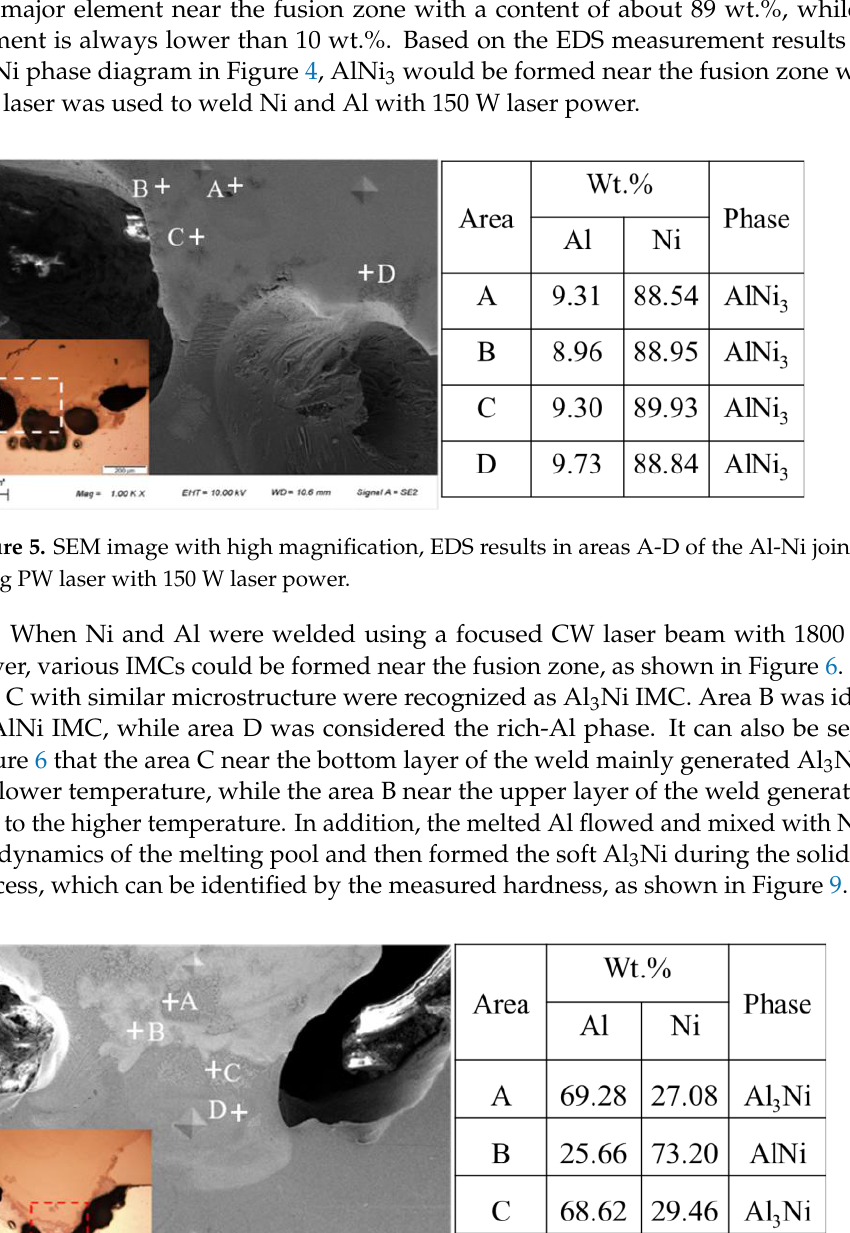
Figure 4. Al-Ni phase diagram. Reprinted/adapted with permission from Ref. [21]. 2019, Springer